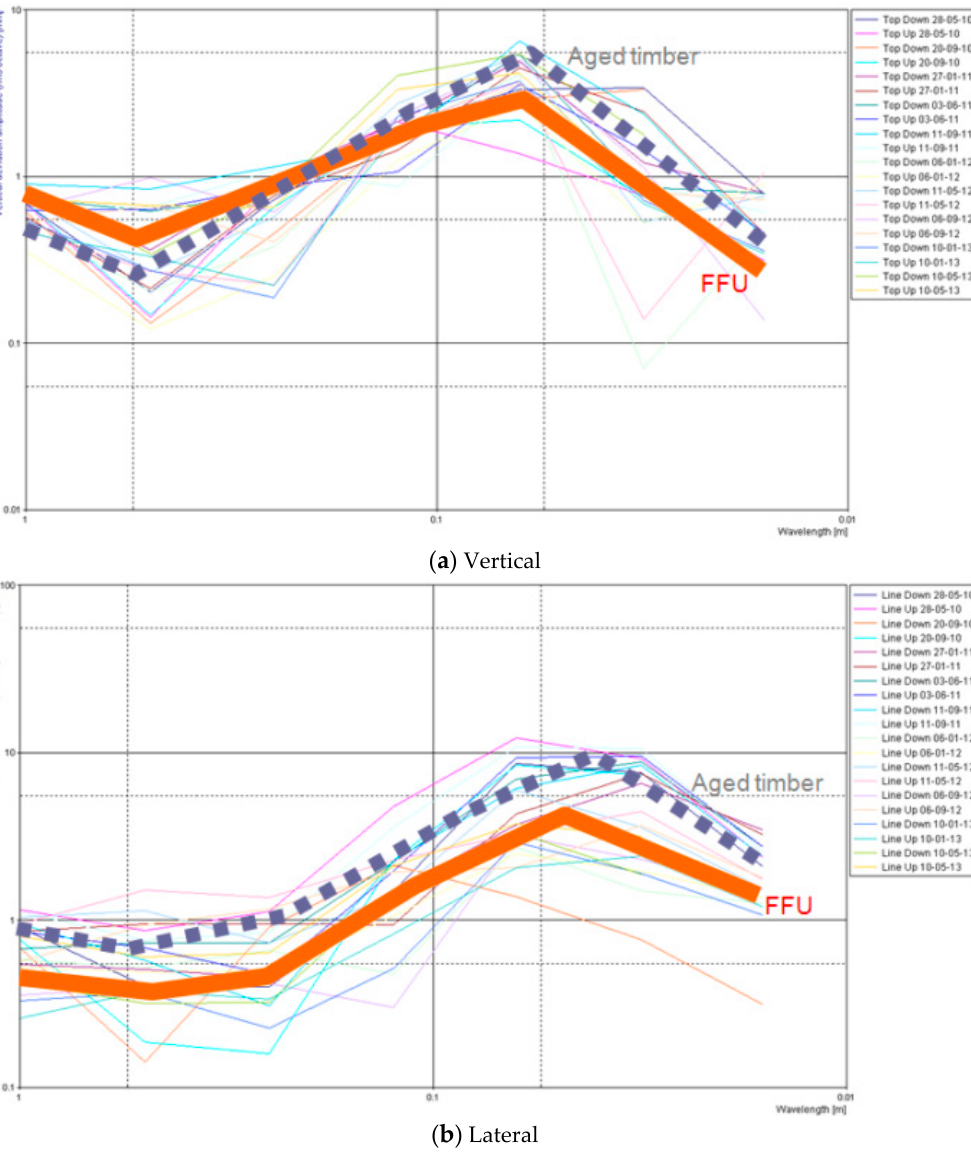
Figure 5. Spectral analysis of track displacements over the double slips. The track geometry data were derived from the axle box accelerations over track length (on time domain series). Its spectral responses imply the movements of track associated with train motions or excitation wavelength (equivalent to surface irregularities). Note that the performance of FFU trials has been monitored after three months of revenue services (to assure appropriate settlement and densification of ballast after construction). More details are in [1–3].